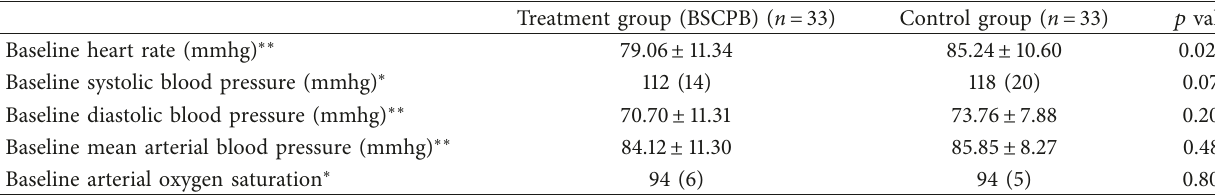
Table 2: Recovery room vital signs between two groups.